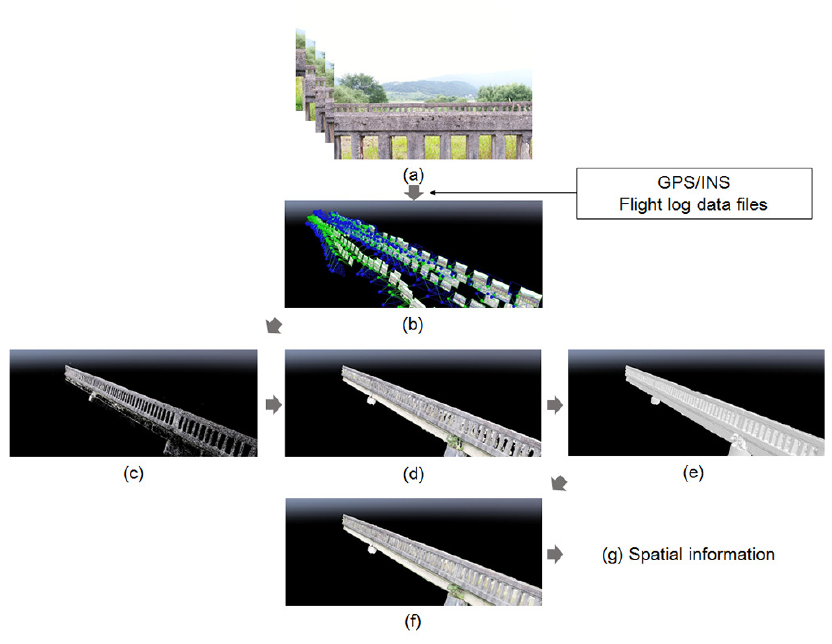
Figure 2. Generating background model to build spatial information: ( a ) Aerial images; ( b ) Geotagged imaged; ( c ) Tie points matching; ( d ) Point clouding; ( e ) Mesh building; ( f ) Texturing and ( g ) Spatial